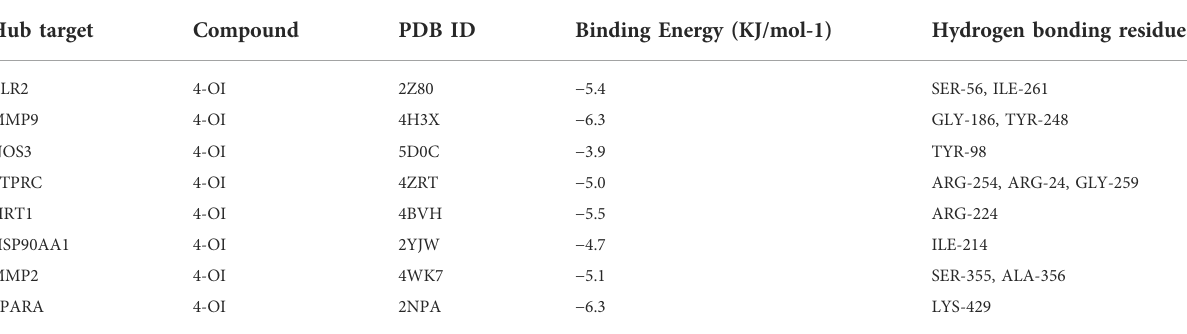
TABLE 3 4-OI-Sepsis molecular